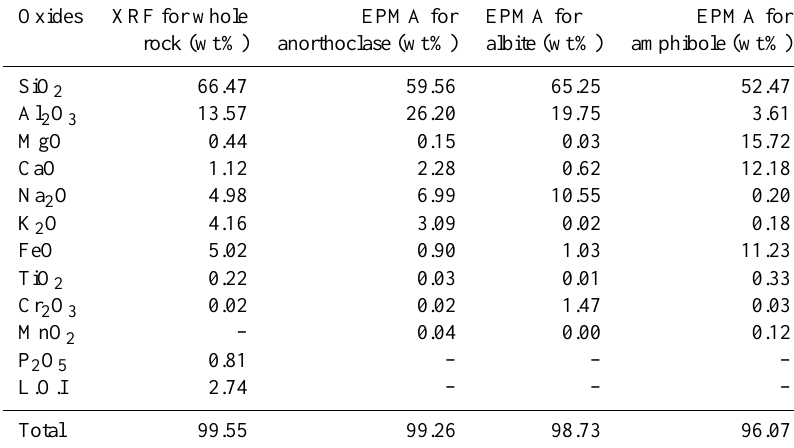
Table 1. Whole rock analysis by X-ray fluorescence (XRF) and chemical composition of dominant minerals for quartz andesite by the electron microprobe